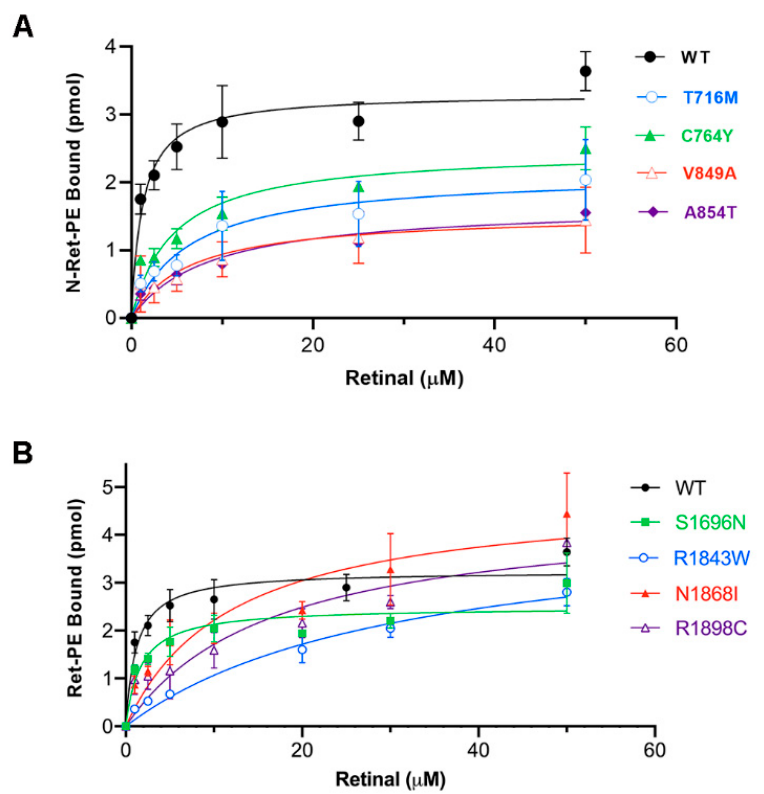
Figure 7. Binding of N -Ret-PE as a function of all-trans retinal concentration for selected TMD variants. ABCA4 TMD variants immobilized on an immunoaffinity matrix were treated with various concentrations of radiolabeled all-trans retinal. The amount of bound N -Ret-PE was determined after the removal of excess retinal. ( A ) Best fit binding curves for TMD1 variants ( n ≥ 2) for the following apparent mean Kd ± SD; WT Kd = 1.2 ± 0.2 µ M; p.T716M Kd = 6.3 ± 0.7 µ M; p.C764Y Kd = 4.6 ± 0.4 µ M; p.V849A Kd = 6.4 ± 0.9 µ M; p.A854T Kd = 8.6 ± 0.9 µ M. ( B ) Best fit binding curves for TMD2 variants for n ≥ 2; Kd = p.E1399K Kd = 2.8 ± 0.3 µ M; p.S1696N Kd = 3.5 ± 0.3 µ M; p.R1843W Kd = 31 ± 3.5 µM; p.N1868I Kd = 12.0 ± 0.8 µM; p.R1898C Kd = 16.0 ± 1.7 µM.